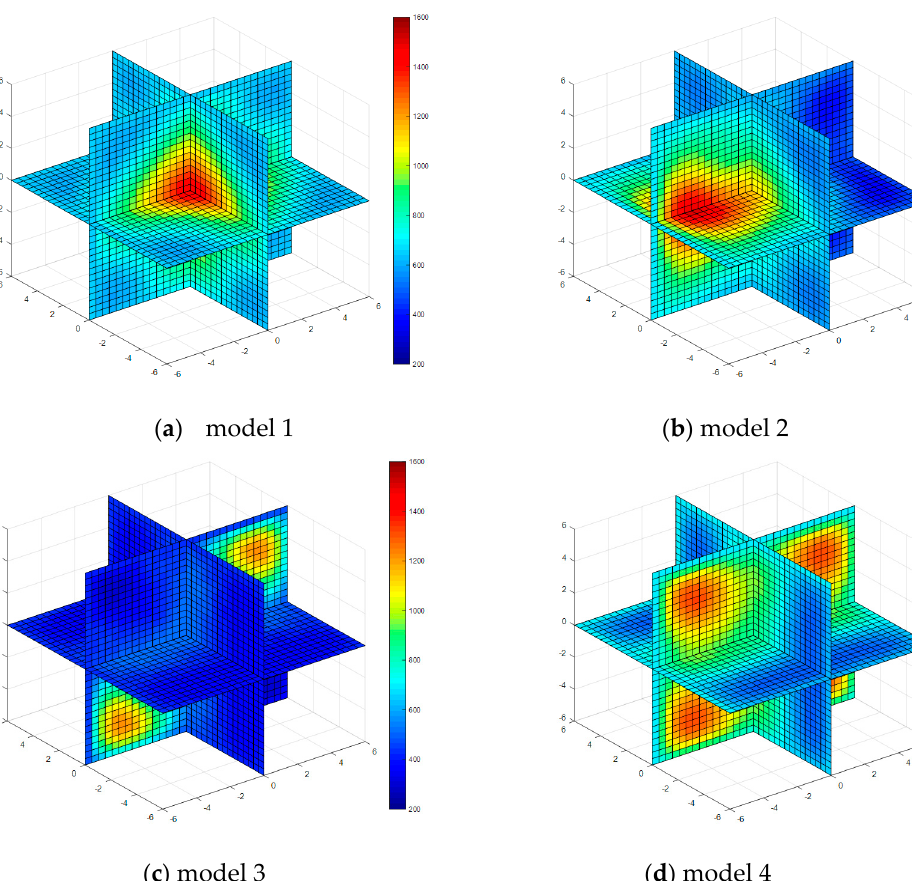
Figure 4. Diagram of reconstructed temperature fields by the least squares method.